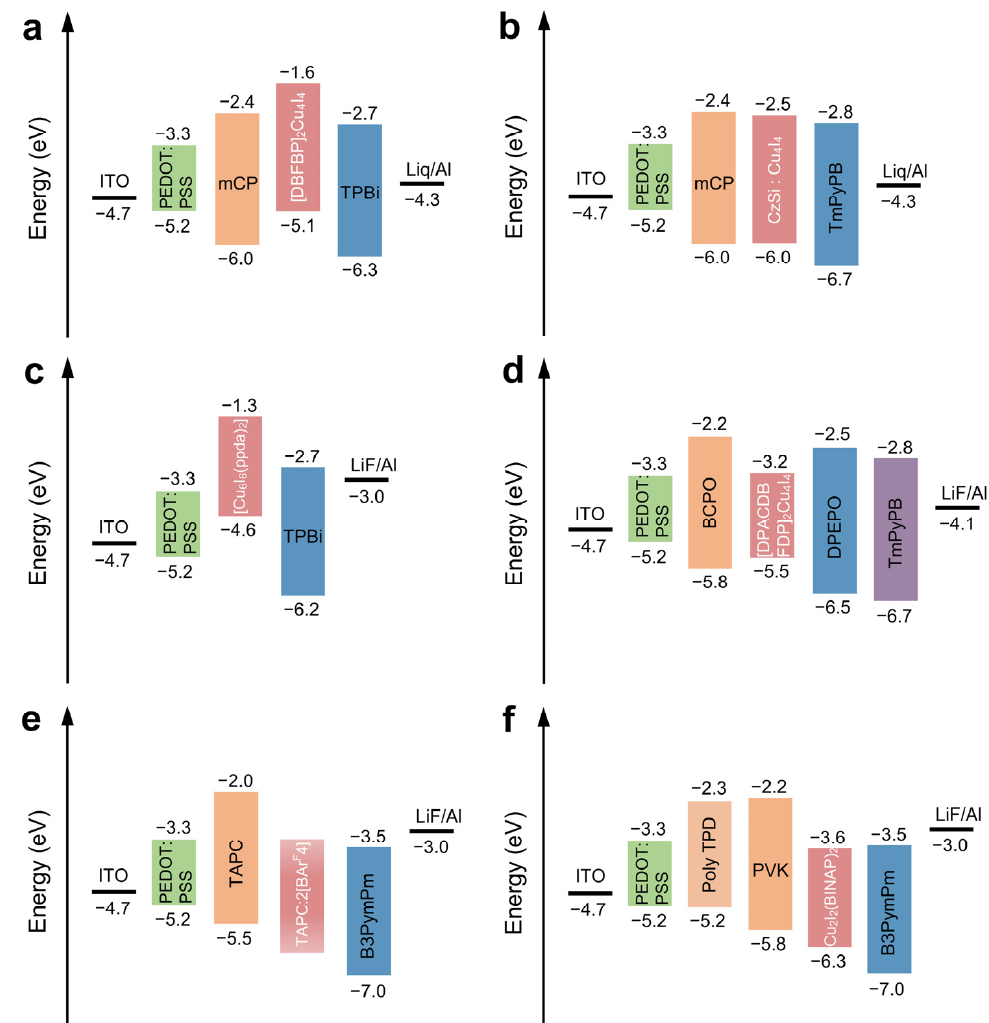
Figure 9d. The electroluminescent LEDs exhibit a stable yellow emission with International Commission on Illumination (CIE) coordinates of (0.43, 0.51), a maximum EQE of 0.31%, and a maximum CE of 0.85 cd A − 1 . In 2020, Marian et al. reported cationic organocopper NCs [Cu 4 (PCP) 3 ] + (PCP = 2,6-(PPh 2 ) 2 C 6 H 3 ), which have the characteristic of inhibiting nonradiative decay and a robust narrow-band green luminophore, and their PLQY is as high as 93%. The PL decay kinetics confirmed by density functional theory (DFT) calcula- tions reveal a complex emission mechanism involving both TADF and phosphorescence contributions. Experiments found that after the NCs were prepared into electroluminescent LEDs by a solution treatment, the material had an EQE of up to 11% and a narrow emission bandwidth (65 nm FWHM). The device structure is shown in Figure 9e.